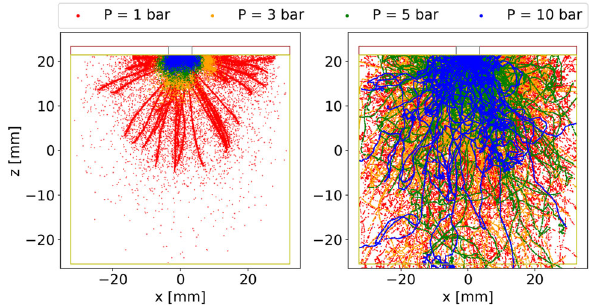
Fig. 8 Simulated tracks obtained at different pressures for a cross sec- tion of the setup, for α (left) and β (right) tracks emitted from the source surface (upper rectangle)